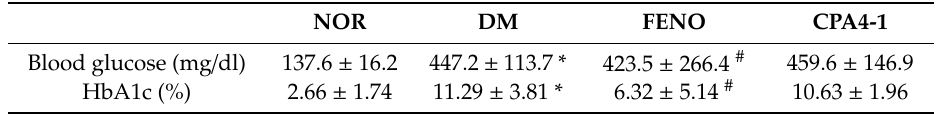
Table 4. Blood and liver parameters in the serum of db/db mice treated with FENO and CPA4-1.